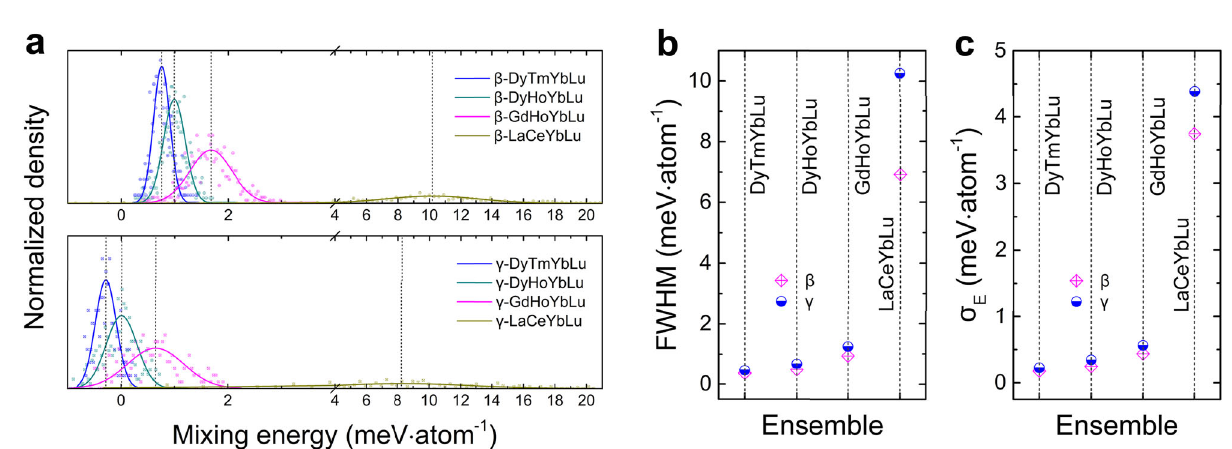
(cid:5) (cid:6) 4 E = 5 E (cid:3) E isused,and N ′ isthetotalnumberofthesampledmicrostates max min N 0 in an ensemble. The solid lines are the Gaussian fi tting of the E i distribution spec- trum. b The full width at half maximum (FWHM) of the Gaussian- fi tted E i dis- tribution spectrum. c The standard deviation of mixing energy ( σ E ) for all the con fi gurations in each ensemble.